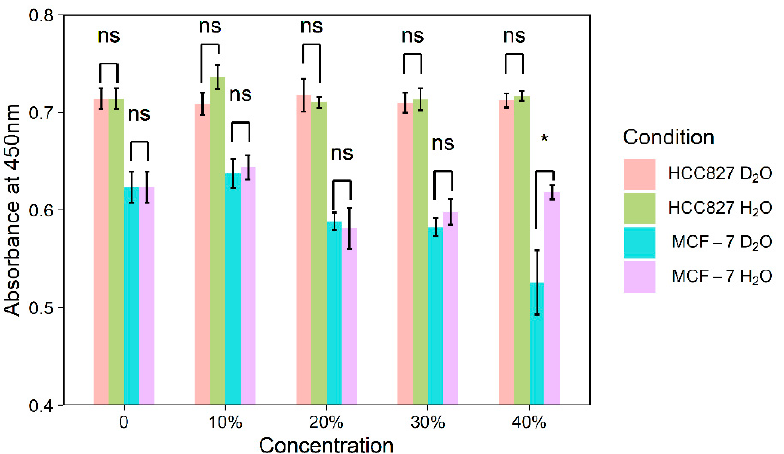
Figure 4. Relative cell viability after 24 h of incubation in D 2 O and H 2 O. Error bars represent the standard deviation of eight replicates. *: p ≤ 0.05; ns: p > 0.05, no significance.